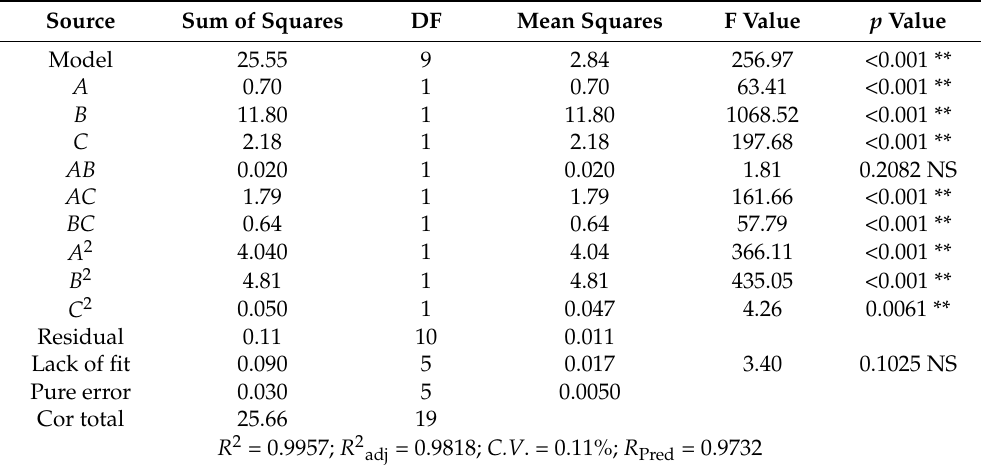
Table 5. Regression variance analysis for the pickup